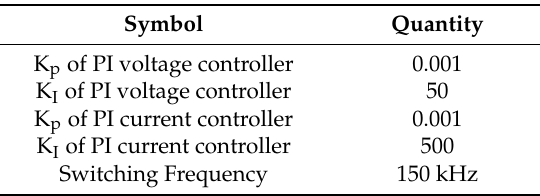
Table 3. Controller parameters of comparison PI